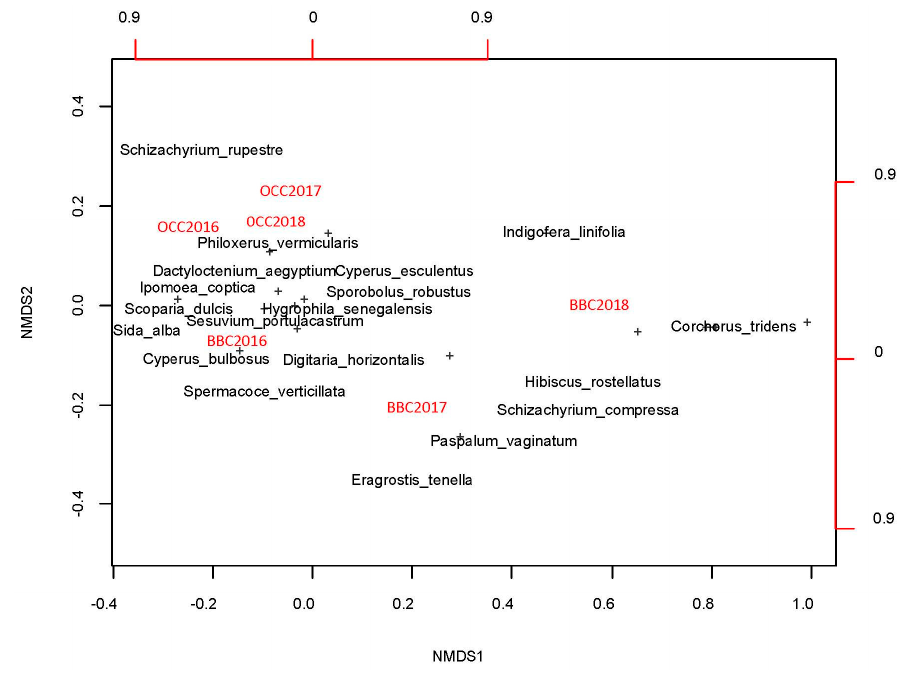
Figure 4. Non-metric multidimensional scaling (NMDS) ordination of species composition below Casuarina canopy (BBC) and outside Casuarina canopy (OCC) in 2016, 2017, and 2018.